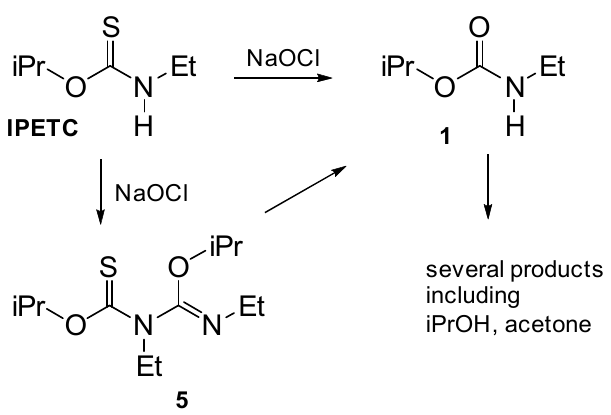
Scheme 4. Transformation pathway of IPETC in the presence of NaOCl.